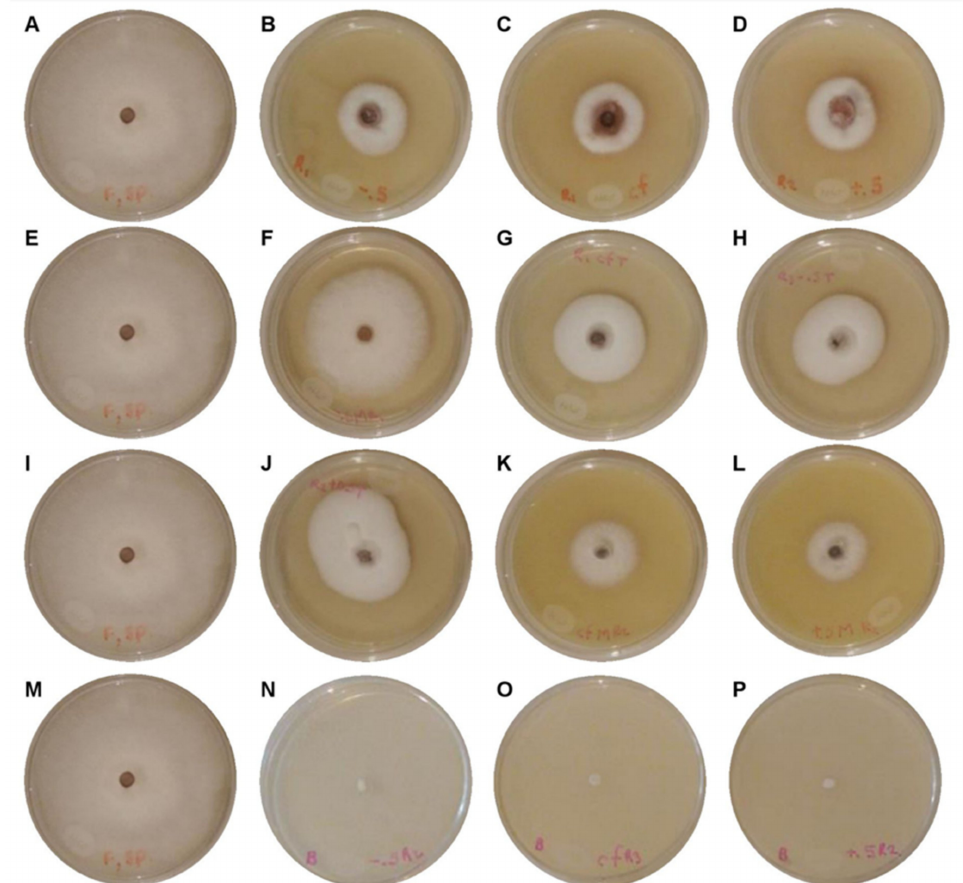
Figure 4. Strain MA-FC120 (FSSC) in culture medium with fungicide. ( A , E , I , M ) Controls; Captan 50 ® : ( B ) 450 mg L − 1 , ( C ) 900 mg L − 1 , ( D ) 1350 mg L − 1 ; Mancosol 80 ® : ( F ) 600 mg L − 1 , ( G ) 1200 mg L − 1 , ( H ) 1800 mg L − 1 ; Talonil 75 ® : ( J ) 450 mg L − 1 , ( K ) 900 mg L − 1 , ( L ) 1350 mg L − 1 ; Benomyl 50 ® : ( N ) 250 mg L − 1 , ( O ) 500 mg L − 1 , and ( P ) 750 mg L − 1